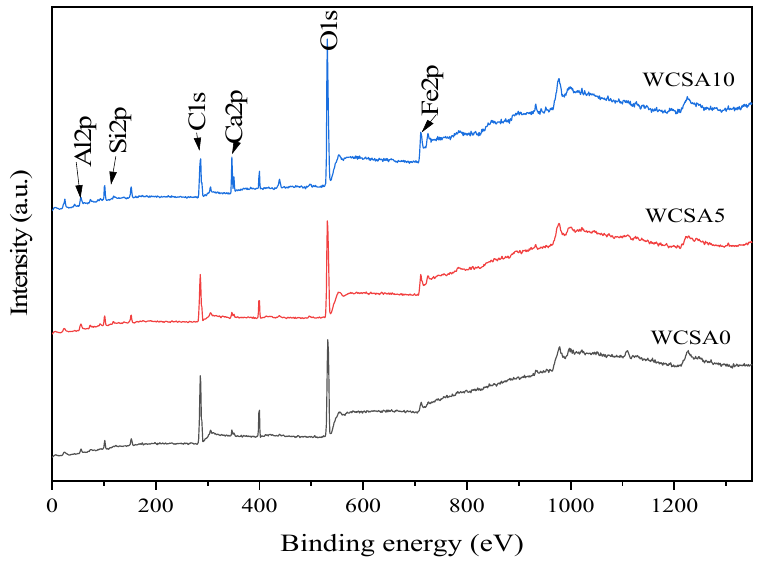
Figure 6. XPS measurement spectrum of WCS containing different Al 2 O 3 .